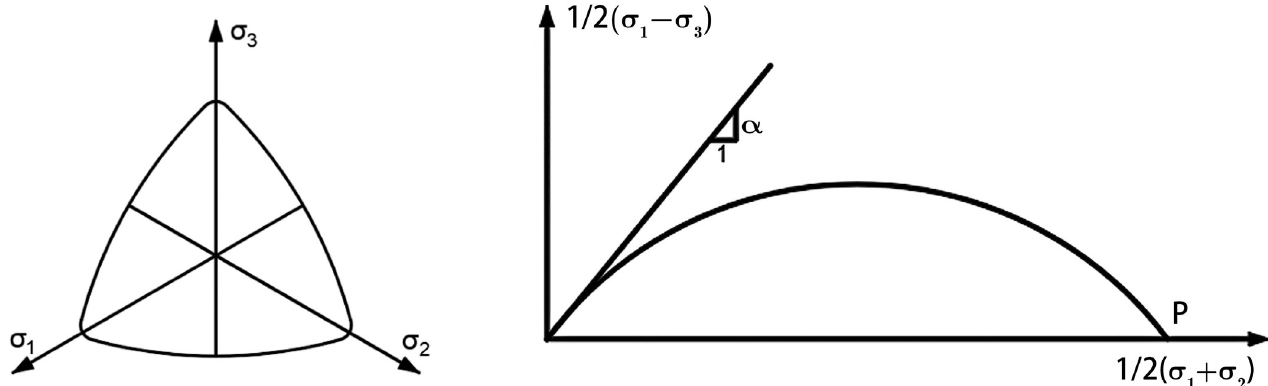
Fig 2. Instantaneous yield